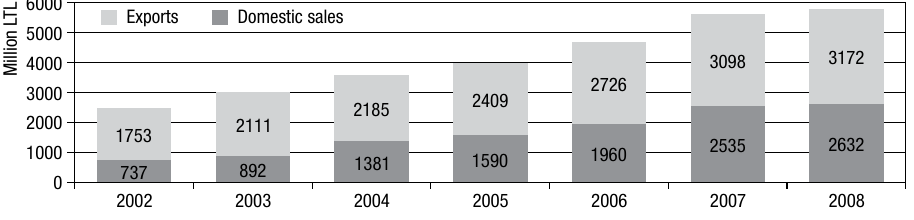
Fig. 10. Sales of wood, paper products and furniture in Lithuania (LTL million)